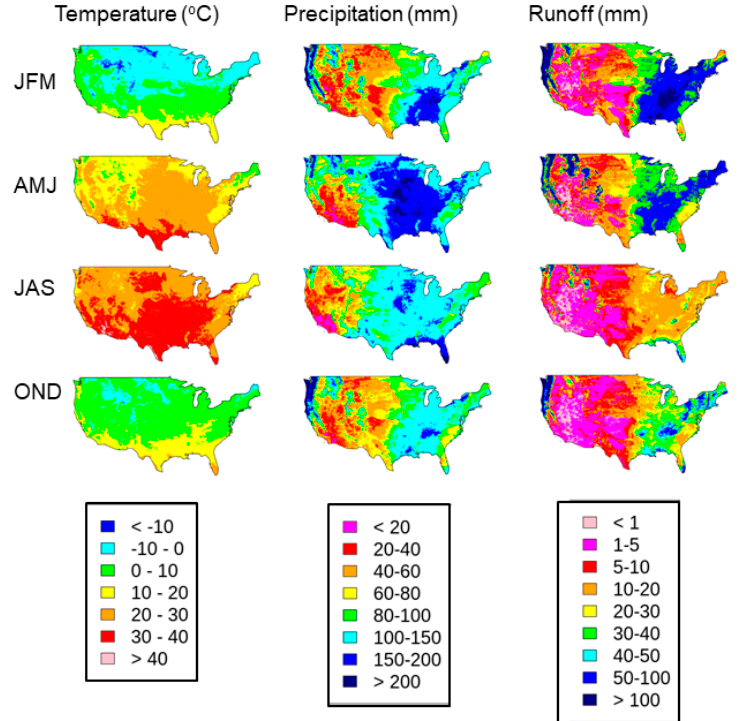
Figure 1. Baseline (1981–1999) climatic conditions for seasonal average monthly temperature in degrees Celsius (°C), precipitation in millimeters (mm), and runoff in mm. JFM, January–March; AMJ,